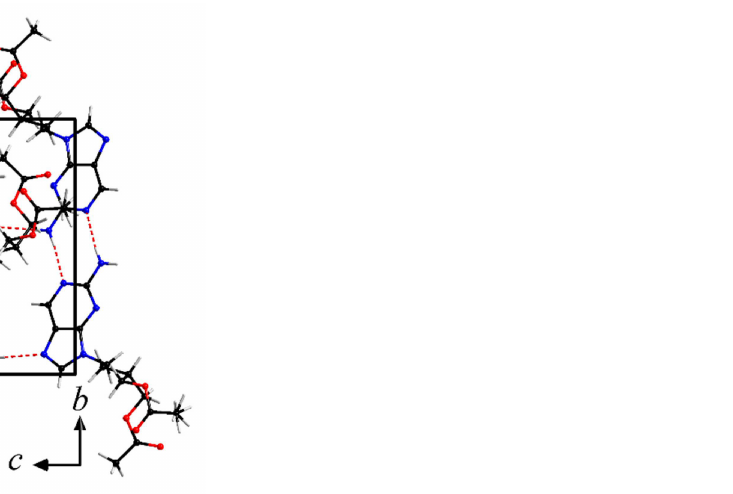
Figure 8. Crystal structure of anhydrous famciclovir (form I). View along cell axis a . Hydrogen bond interactions are shown as red dotted lines.